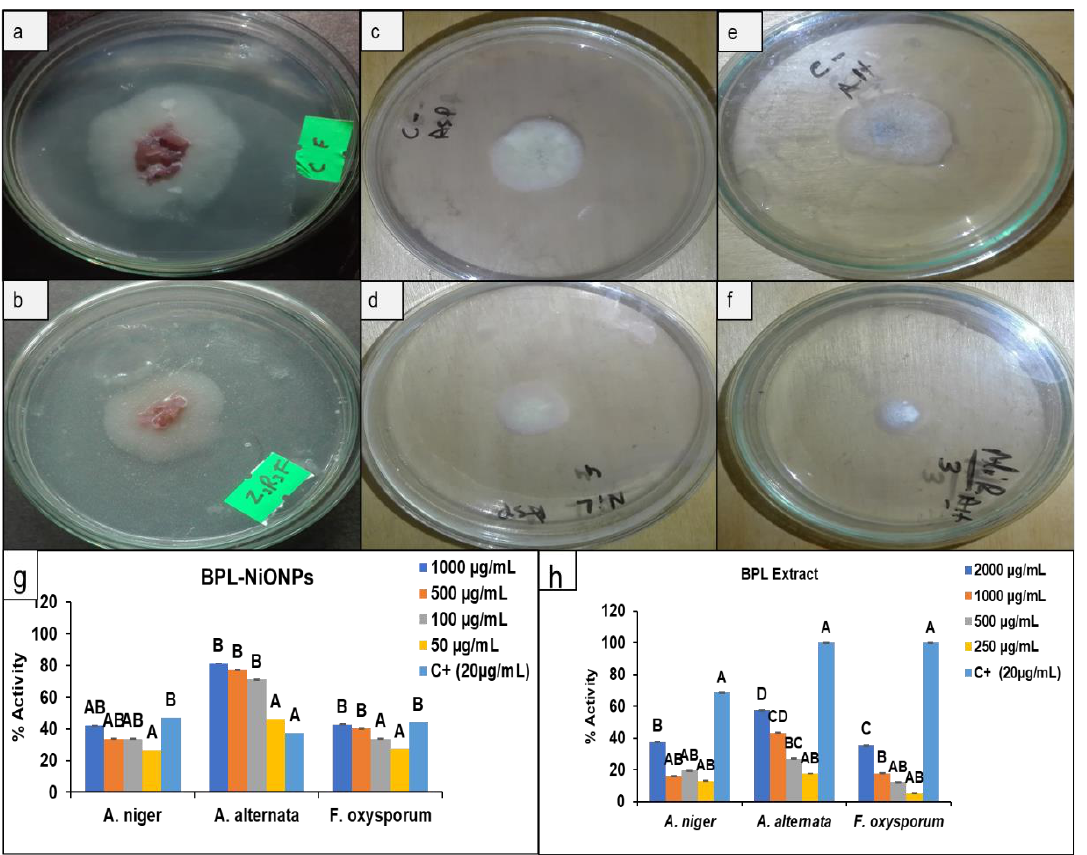
Figure 6. Antifungal analysis of Berberis pachyacantha leaf extract (BPL) BPL-NiONPs at 1000 µg/mL against F. oxysporum : ( a ) control (non-treated) and ( b ) treated with BPL-NiONPs; A. niger : ( c ) control (non-treated) and ( d ) treated with BPL-NiONPs; and A. alternata : ( e ) control (non-treated) and ( f ) treated with BPL-NiONPs. Antifungal activity: ( g ) BPL extract; ( h ) BPL-NiONPs. C+ refers to positive control (fluconazole). The obtained data are presented as mean ± standard deviation ( n = 3). Letters specify a significant difference ( p < 0.05) between control and BPL-NiONPs treated samples.